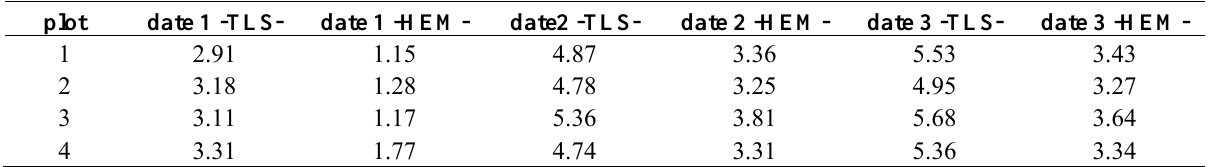
Table 1. LAI values calculated for the four different plots using terrestrial laser scanning (TLS) and hemispherical photography (HEM).